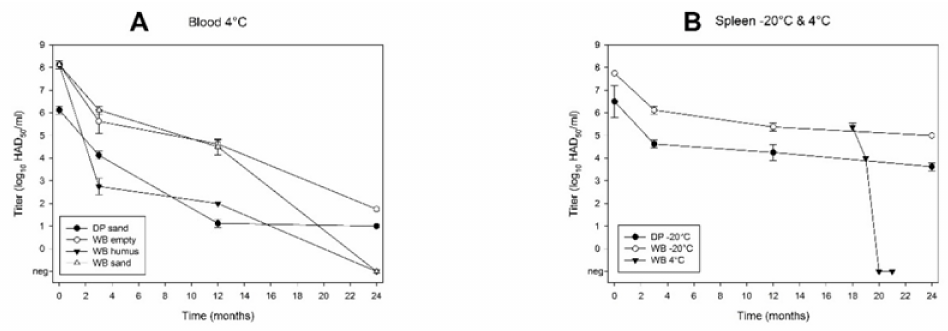
Figure 3. Comparison between qPCR and HAT results for muscle ( A – C ), skin ( D – F ) and faeces ( G – I ) of domestic pigs (DP) and wild boar (WB) during storage in empty boxes or on di ff erent matrices (humus, sand, decomposition island [decomp.], waste, water) at − 20 ◦ C, 4 ◦ C and room temperature (RT).